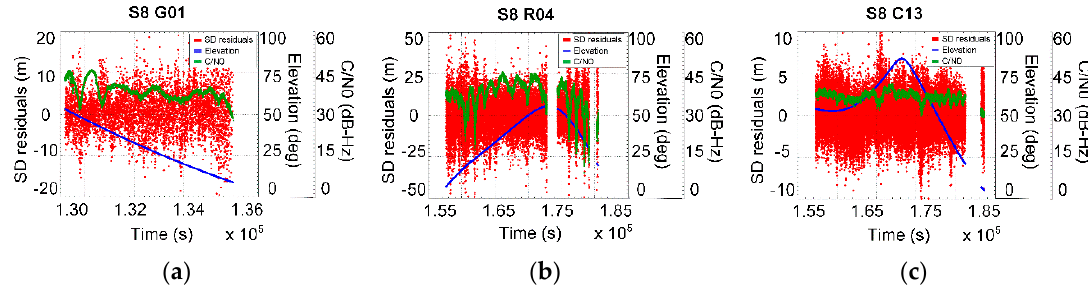
Figure 8. The regularity of station single-difference residuals, elevation, and C/N0 change with time. ( a ) The number 1 satellite of GPS (G01); ( b ) the number 4 satellite of GLONASS (R04); ( c ) the number 13 satellite of BDS (C13).